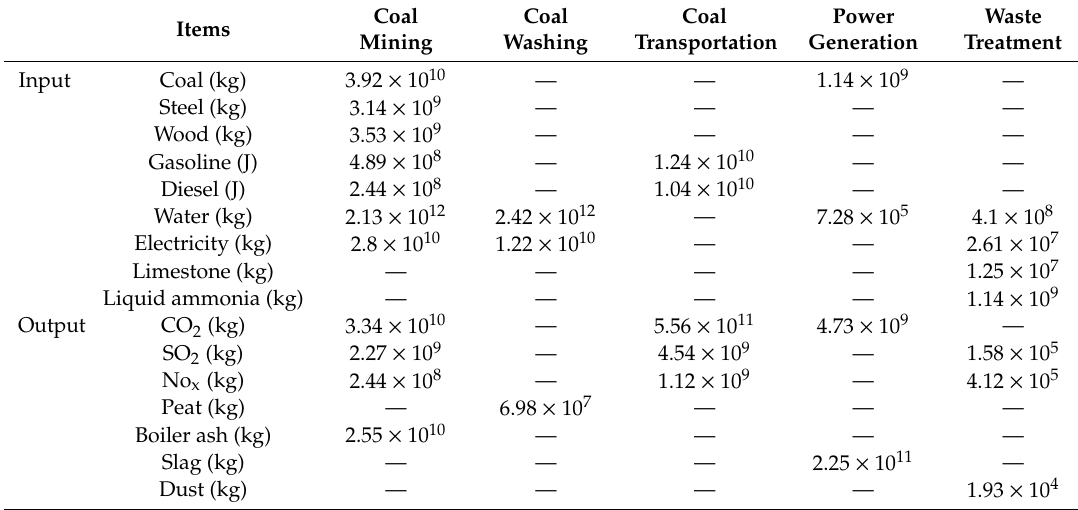
Table 1. Life cycle inventory of a 600 MW coal-fired generating unit (Unit 1).